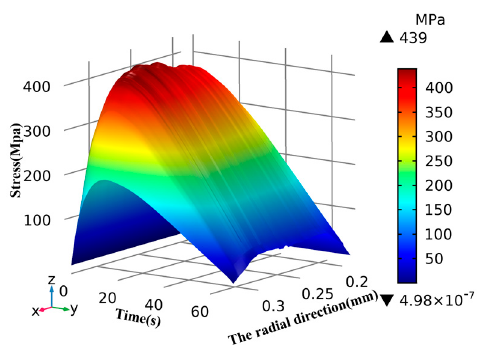
Figure 15. Three-dimensional cloud of time-stress along the radial direction of a ventilated brake disc.